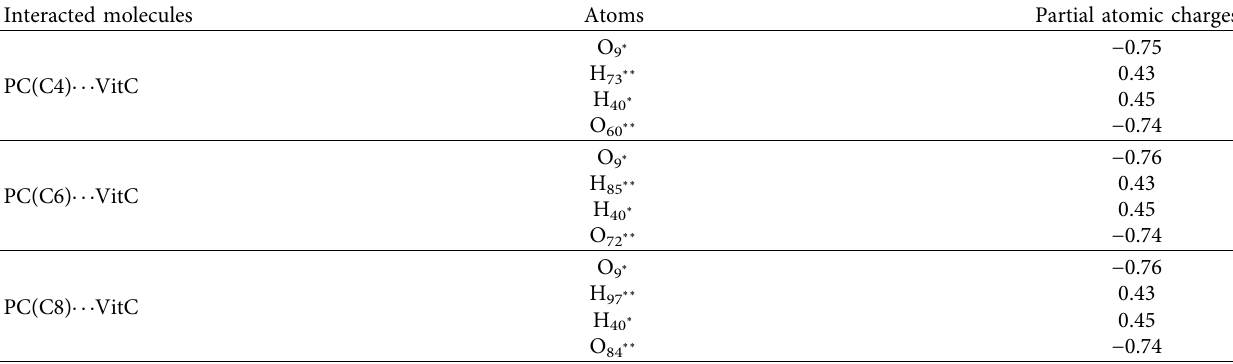
Table 5: Partial atomic charges in the region of interaction between phospholipid ∗ and vitamin C ∗∗ . Interacted molecules Atoms Partial atomic